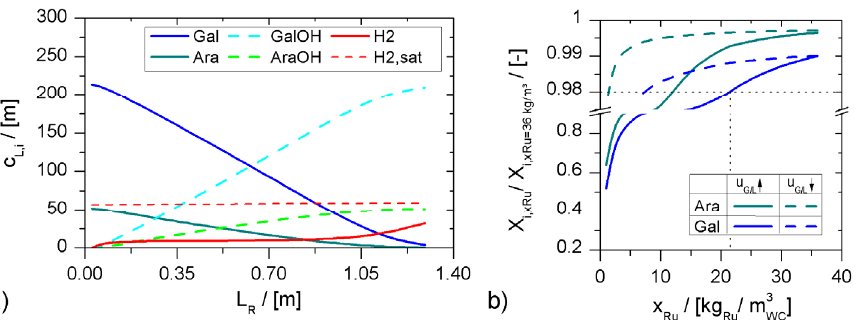
Figure 21. ( a ) Axial concentration profiles of all components in the liquid phase within the trickle-bed reactor at u L , s = 0.03 m/s, u G , s = 0.125 m/s, x Ru = 21.5 kg /m 3 and ( b ) effect of reduced ruthenium content on the conversion of both reactants for high throughput ( u G / L ↑ : u L , s = 0.03 m/s, u G , s = 0.125 m/s, 𝐿 (cid:3019) = 1.29 m ) and low throughput (𝑢 (cid:3008)/(cid:3013) ↓ : 𝑢 (cid:3013),(cid:3046) = 0.001 m/s , 𝑢 (cid:3008),(cid:3046) = 0.01 m/s , 𝐿 (cid:3019) = 1.74 m ).